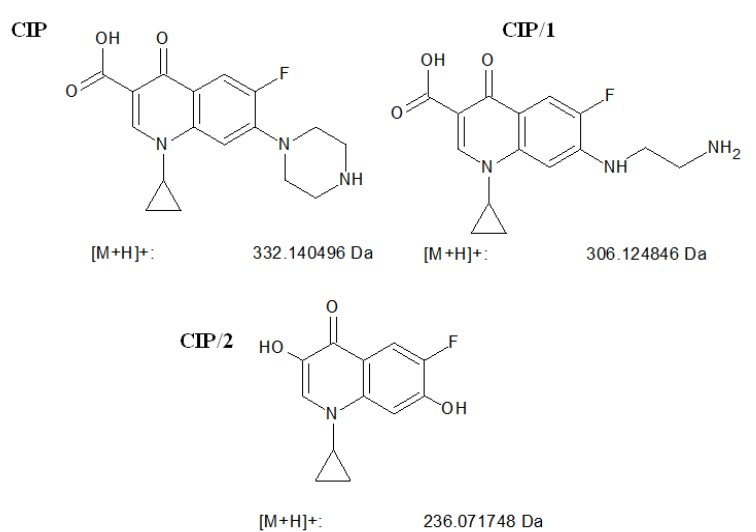
Figure 16. The structure of CIP, and the suggested structure and calculated masses of the formed ions of the detected stable products.